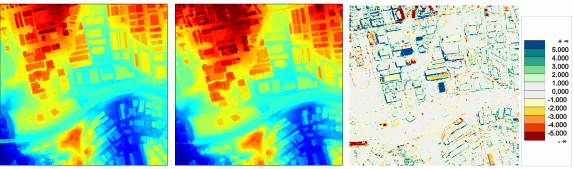
Figure 4: Left: DSM from Laser scanning Middle: DSM com- puted from object space SGM Right: Difference between the two